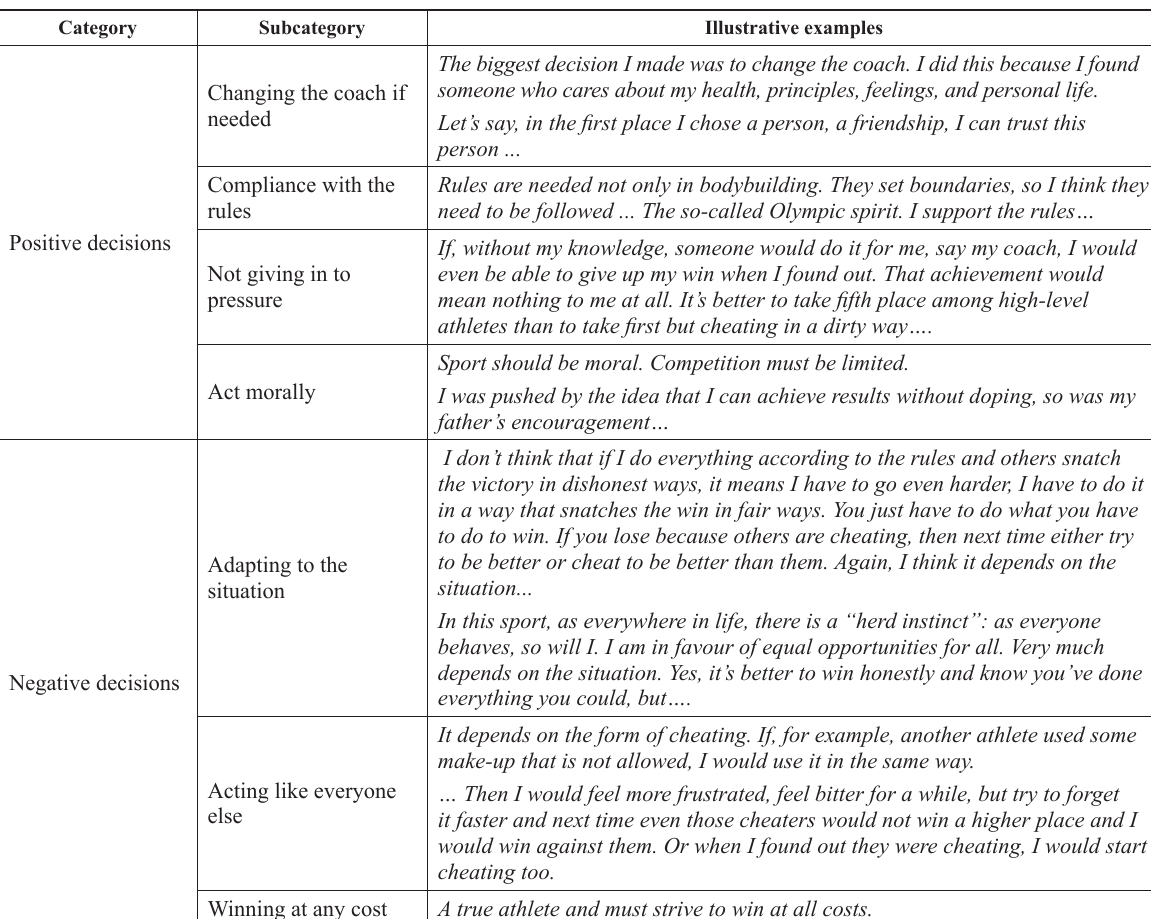
Table 7. The most important moral decisions have been made